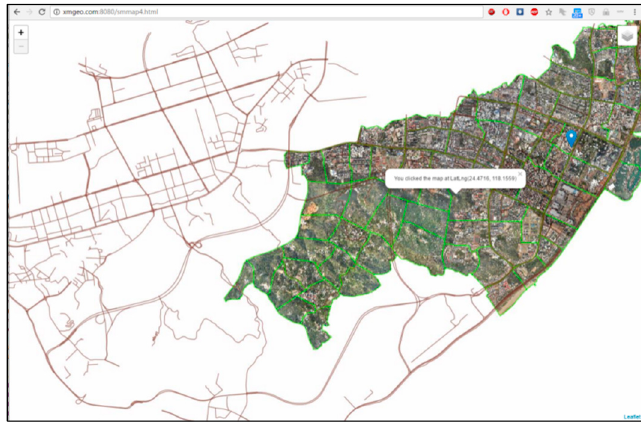
Figure 12. Vector layer release.